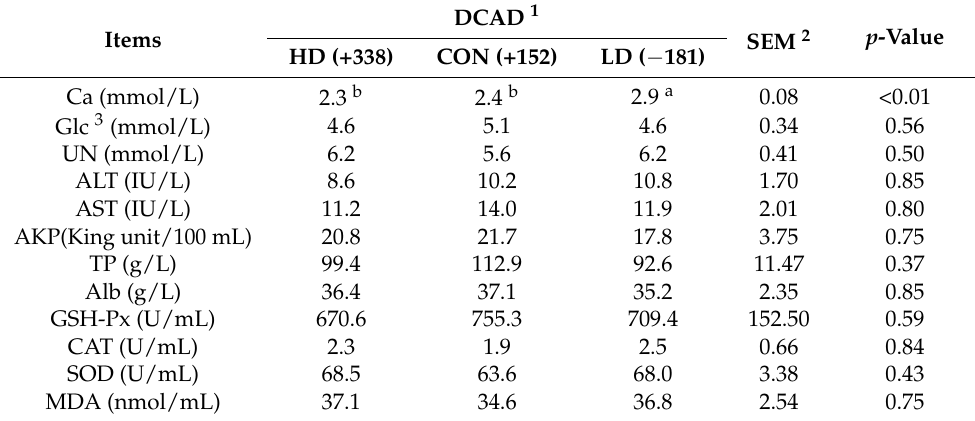
Table 7. Effect of varying dietary cation-anion difference on the plasma metabolites of female goats.